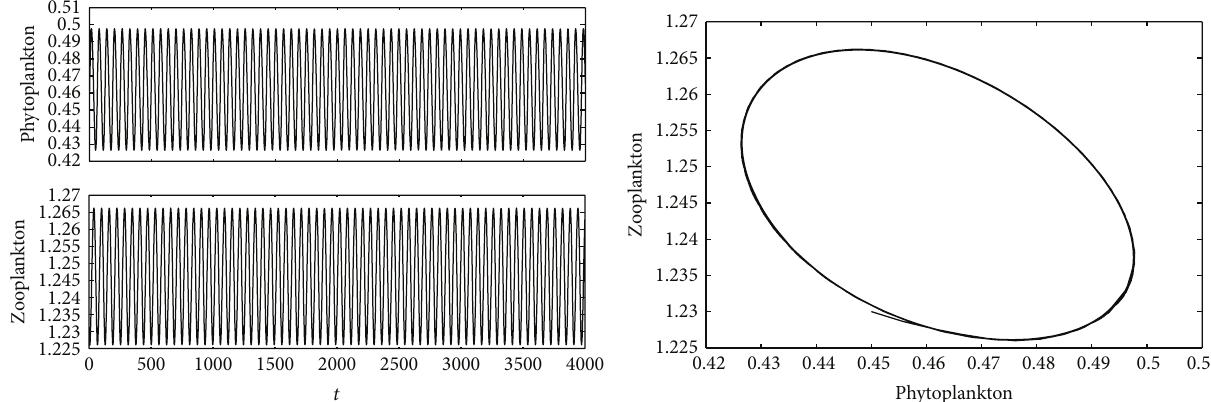
Figure 5: Behavior and phase portrait of system (4) with 𝜏 = 5.11 = 𝜏 0 . Hopf bifurcation occurs from the interior equilibrium 𝐸 ∗ 12 . The initial value is (𝜙(0),𝜑(0)) = (0.45, 1.23)